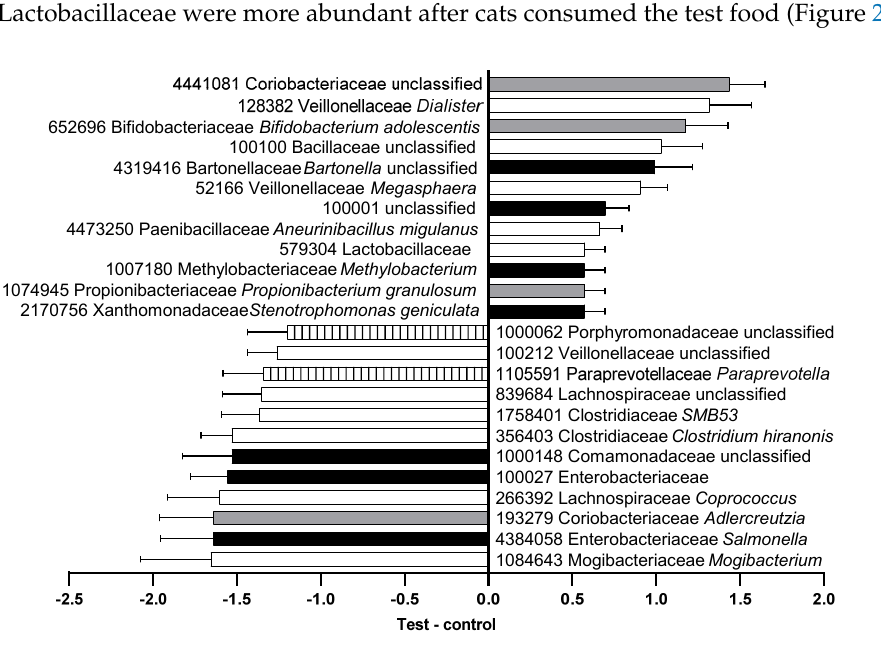
Figure 2. Relative abundance (center log-ratio) of the difference between feces from the test and control food groups in operational taxonomic units (OTU) that were significantly different. OTU number, family, and genus are shown with species where available. Black, phylum Proteobacteria; gray, phylum Actinobacteria; white, phylum Firmicutes; striped, phylum Bacteroidetes.